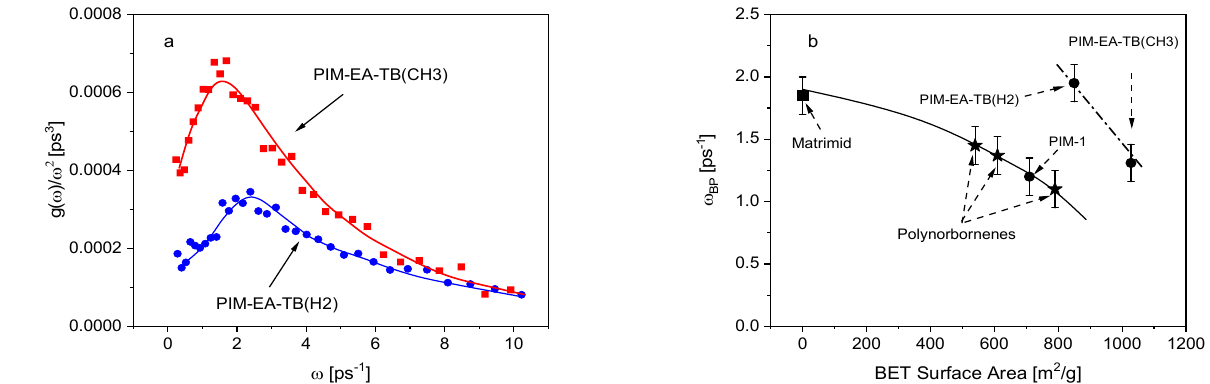
Figure 3. ( a ) Low frequency density of states divided by ω 2 vs. frequency for PIM-EA-TB (CH 3 ) (red squares) and PIM- EA-TB(H 2 ) (blue circles). The lines are guides for the eyes. ( b ) Maximum frequency of the Boson peak versus BET surface area. Squares—Matrimid, data was taken from [58]. Asterisks—polynorborenes, where the data was taken from [53], Circles—Polymers of intrinsic microporosity as indicated. The data for PIM-1 was taken form [56]. Lines are guides for the eye.